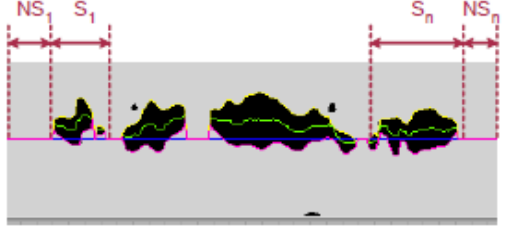
Figure 3. Upper, lower and mean segregation